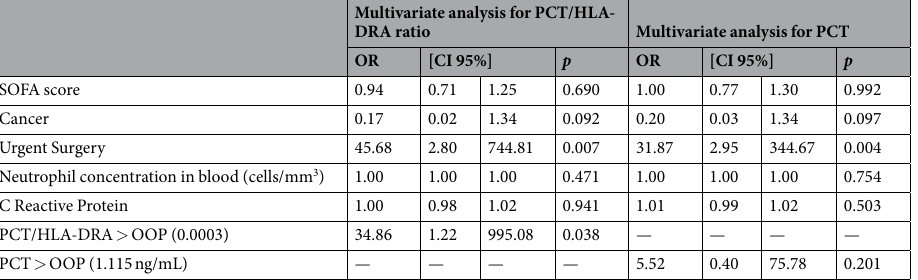
Table 4. Multivariate analysis for evaluating the risk of sepsis in the validation cohort based on the PCT/HLA- DRA ratio or Procalcitonin levels. Optimal operating points (OOP) obtained in the derivation cohort were tested in the validation